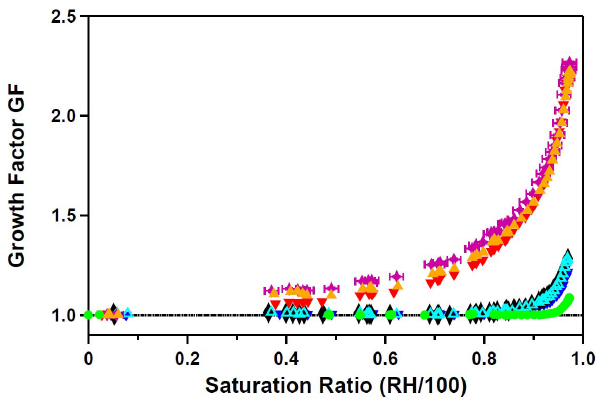
Fig. 12. Experiment in the humidified Large Aerosol Chamber with 470ppb NO x added. Time series of CO 2 (green, left axis), NO − Figure 12. Experiment in the humidified Large Aerosol Chamber with 470 ppb NO X added. (blue, left axis) mass concentrations measured at 900 ◦ C Q-AMS Time series of CO 2 (green, left axis), NO 3- (blue, left axis) mass concentrations measured at vaporizer temperature and total aerosol mass concentration (black, 900 ° C Q-AMS vaporizer temperature and total aerosol mass concentration (black, right axis) right axis) calculated from SMPS volume assuming a density of calculated from SMPS volume assuming a density of 1.8 g cm -3 . Light blue areas: AMS 1.8 g cm − 3 . Light blue areas: AMS vaporizer at 300 ◦ C. Yellow vaporizer at 300°C. Yellow area: the aerosol was dried with a silica gel diffusion drier before area: the aerosol was dried with a silica gel diffusion drier before entering the Q-AMS. entering the